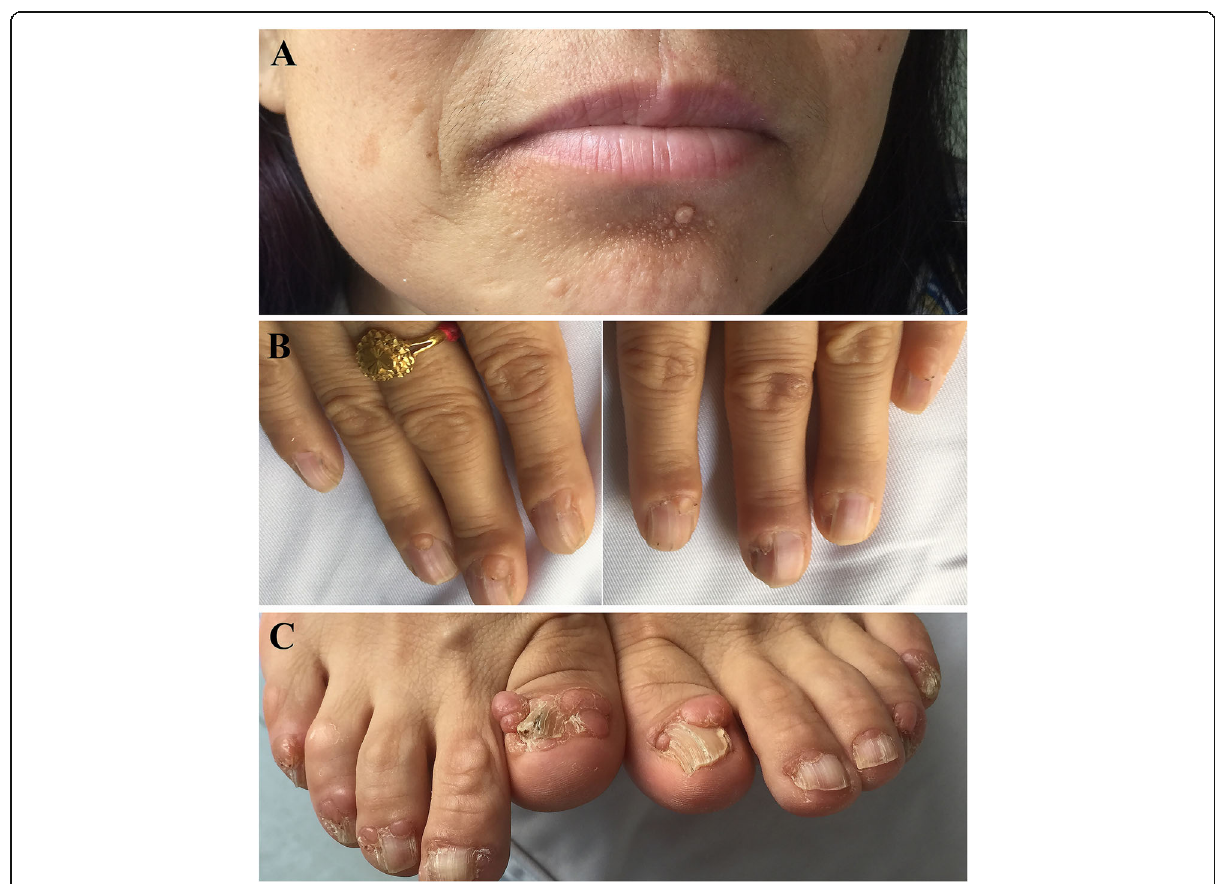
Fig. 2 Clinical photographs of the proband. a . adenoma sebaceum; b , c . subungual